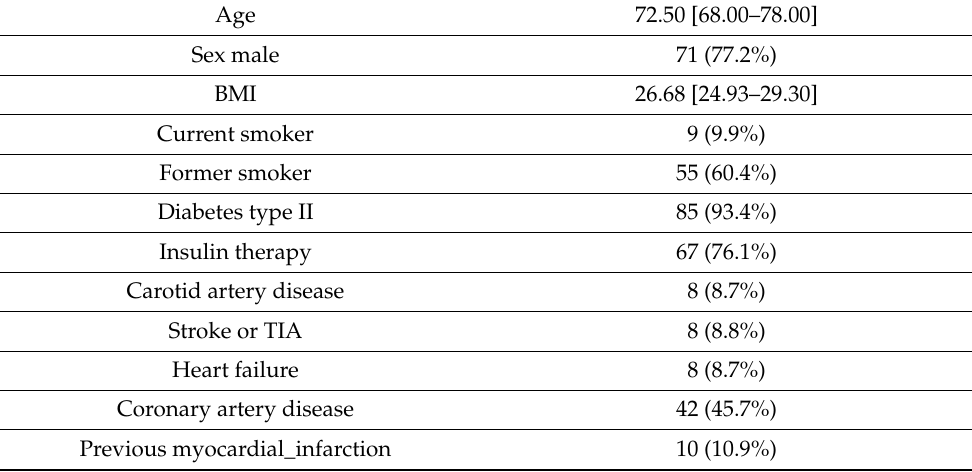
Table 1. Characteristics of the population at the baseline. Continuous variables are expressed as the median and interquartile range. Categorical variables are expressed as the number and percentage of the population. Abbreviations: body max index (BMI); transient ischemic attack (TIA); percutaneous transluminal angioplasty (PTA); estimate of glomerular filtration rate (EGFR); high- density lipoprotein (HDL); low-density lipoprotein (LDL); glycated hemoglobin (Hba1c); c-reactive protein